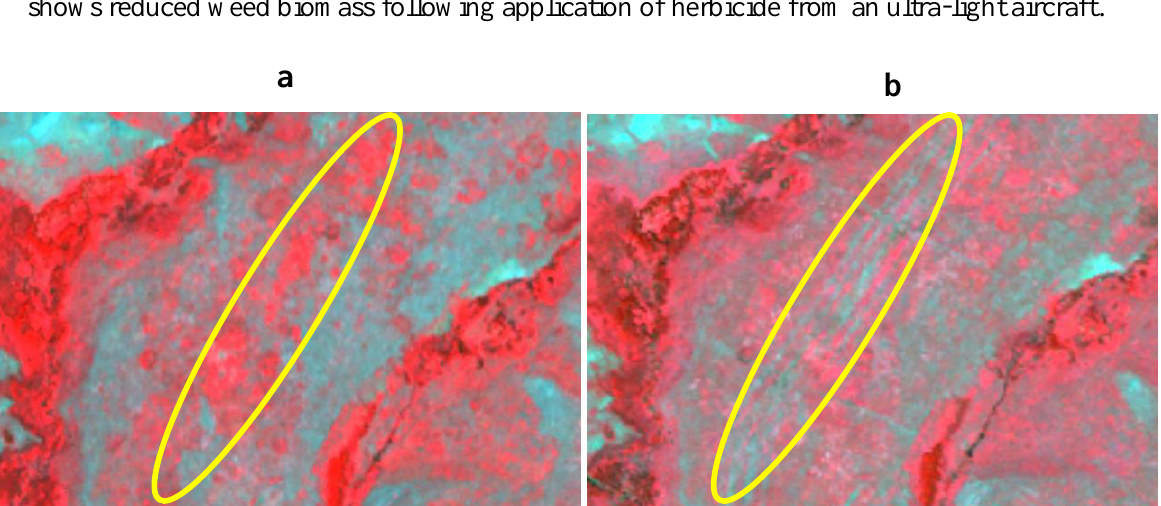
Figure 8. Standard false color composite Ikonos images (bands 4, 3, and 2) in 2001 (a) and 2002 (b). The yellow oval highlights greatest concentration of weeds on valley floor. The dark red regions on the northwest and southeast corners are forested areas on ridges not used for grazing. The 2001 image shows significant weed biomass in red, whereas the 2002 image shows reduced weed biomass following application of herbicide from an ultra-light